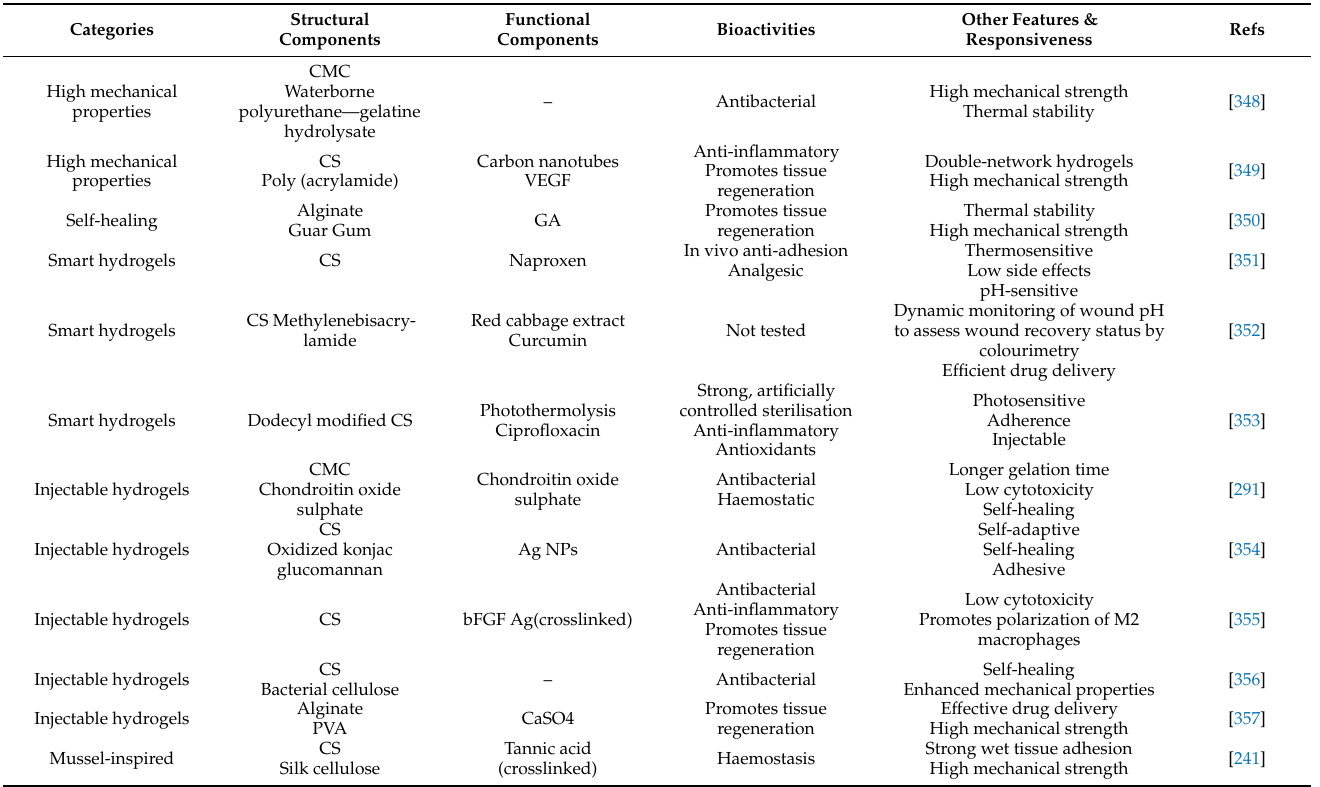
Table 7. Summary of raw materials and characteristics of MPs hydrogels dressings in recent